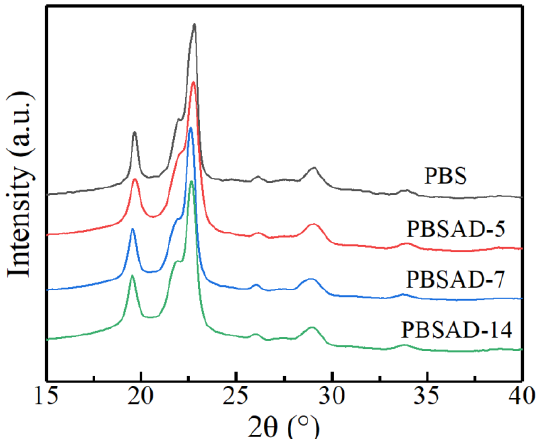
Figure 7. Wide angle X-ray diffractograms of synthesized PBS and